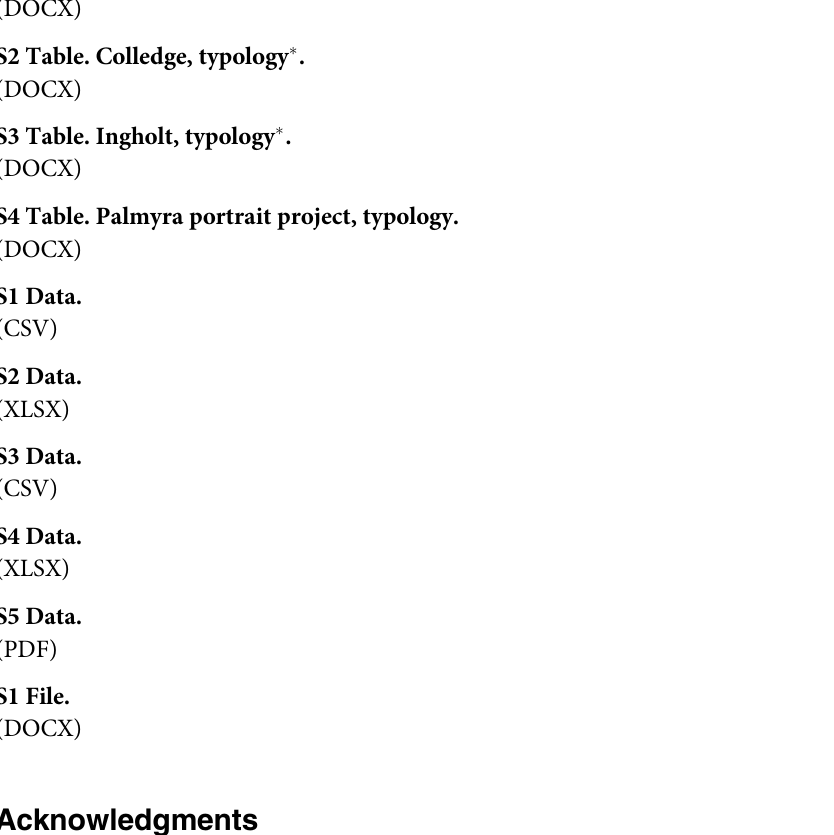
S1 Table. Dated Palmyrene objects.